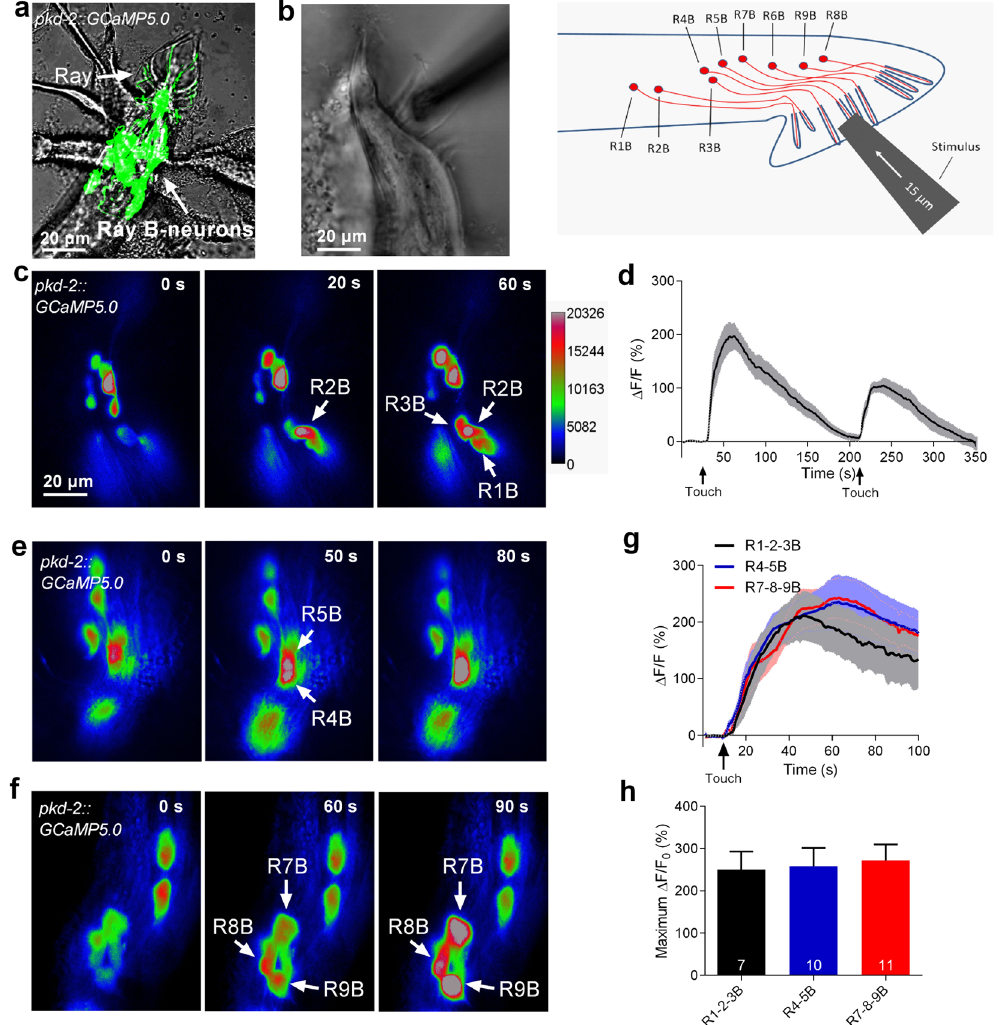
Figure 1. Touch-induced calcium responses in RnB neurons. ( a ) Micrograph of the male tail showing the expression of pkd-2::GCaMP5 . 0 in the rays. All RnB neurons, except R6B, express GCaMP5.0 by the control of the pkd-2 promoter. ( b ) A schematic illustrating of delivering mechanical stimulation toward the RnB cilia (at the position of rays 4–6 is shown). Worms expressing GCaMP5.0 in RnB neurons were immobilized with glue and immersed in a bath solution. ( c ) Representative time-lapse rainbow images of GCaMP5.0 based calcium responses from R1B- R3B neurons induced by mechanical stimulation of 15 μ m displacement at the position of rays 1–3. ( d ) Calcium responses of the R1B- R3B neurons induced by two successive mechanical stimuli of 15 μ m displacement with 180 s interval at the position of rays 1–3. Solid lines show the average fluorescence changes and the shading indicates SEM. n = 10. ( e ) Representative time-lapse rainbow images of GCaMP5.0 based calcium responses from R4B and R5B induced by mechanical stimulation of 15 μ m displacement at the position of rays 4, 5. ( f ) Representative time-lapse rainbow images of GCaMP5.0 based calcium responses from R7B- R9B neurons induced by mechanical stimulation of 15 μ m displacement at the position of rays 7–9. ( g , h ) Calcium responses ( g ) and maximum Δ F/F0 changes ( h ) of the RnB neurons in response to mechanical stimulation. Solid lines show the average fluorescence changes and the shading indicates SEM. n ≥ 7. All error bars represent